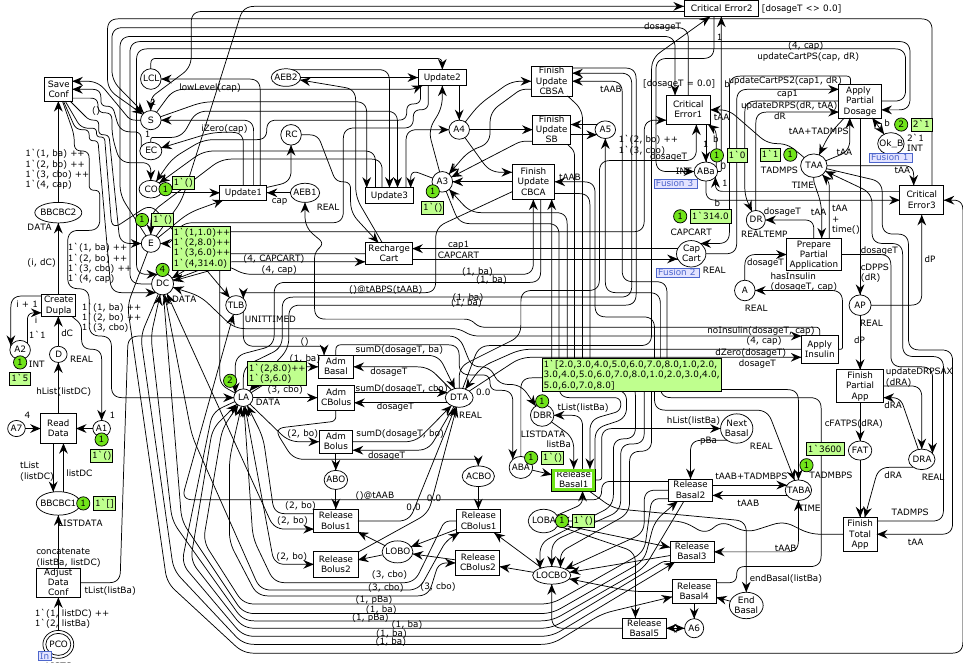
Figure 9. Simulation sample of the ACCU-CHECK Spirit Personalized Infusion